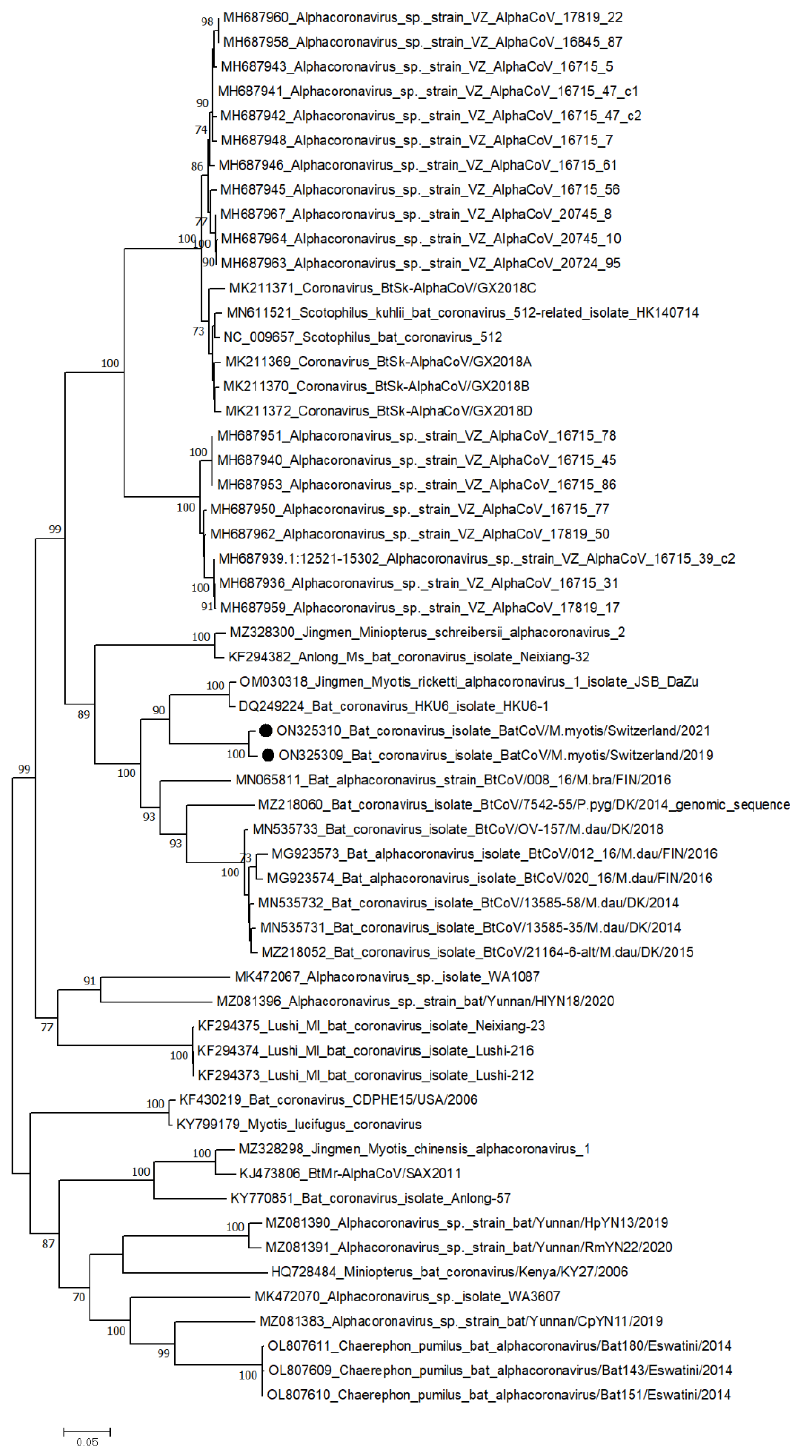
Figure 6. Phylogenetic tree based on nucleotide sequence identity of the NS12 protein (which includes RdRp ) of selected alpha-coronaviruses. Sequences found in this study are marked by black dots. Phylogenetic analysis was performed using the Maximum likelihood algorithm based on the Tamura–Nei model with the 1000 replications bootstrap method. Only values ≥ 70% are displayed. Evolutionary analyses were conducted in MEGA